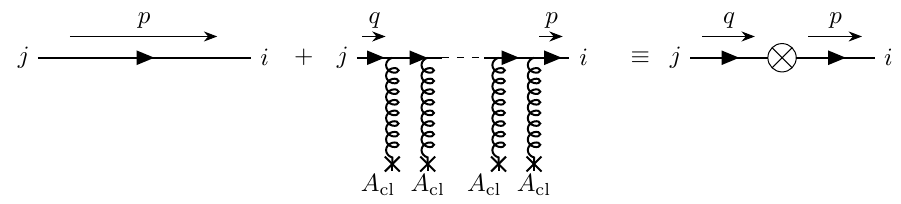
Figure 7 . Diagrammatic representation of the dressed quark propagator in eq. (B.1) as a sum of the “no-scattering” contribution as shown by the free propagator on the left and all possible multiple scattering with the background classical field A cl of small x gluons. i and j denote the color indices in the fundamental representation of SU( N c )